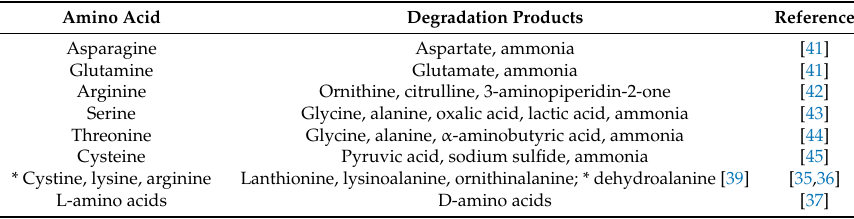
Table 1. Amino acid modification during alkaline